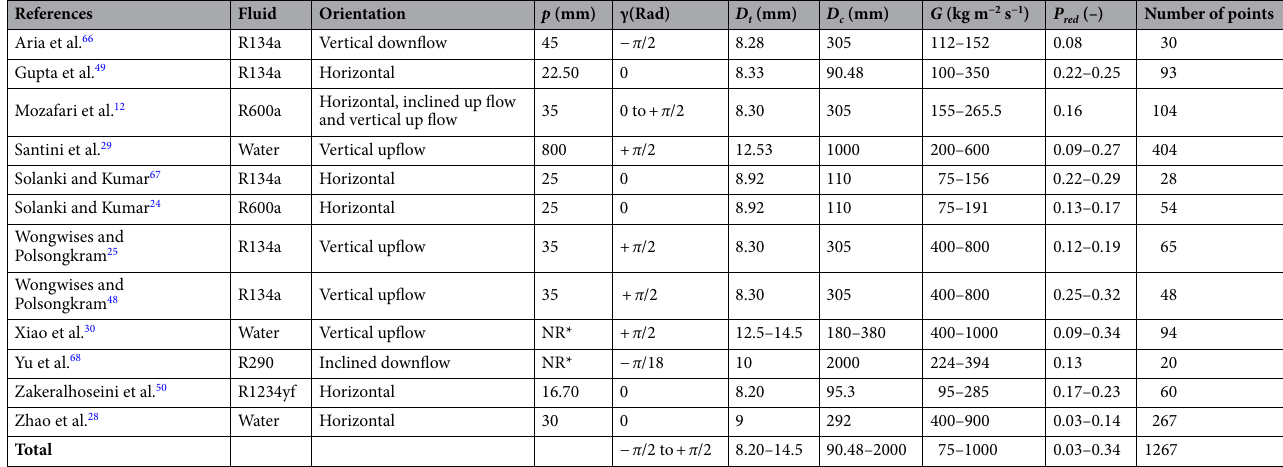
Table 2. The analyzed data sources for FPD in coiled tubes. *Not reported.